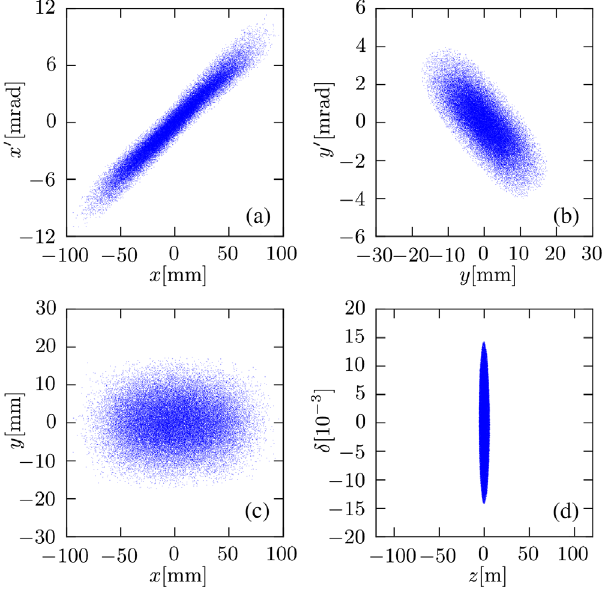
FIG. 3. Particle distribution in (a) x − x 0 phase space; (b) y − y 0 phase space; (c) x − y space; and (d) longitudinal z − δ phase space after bunch compression.